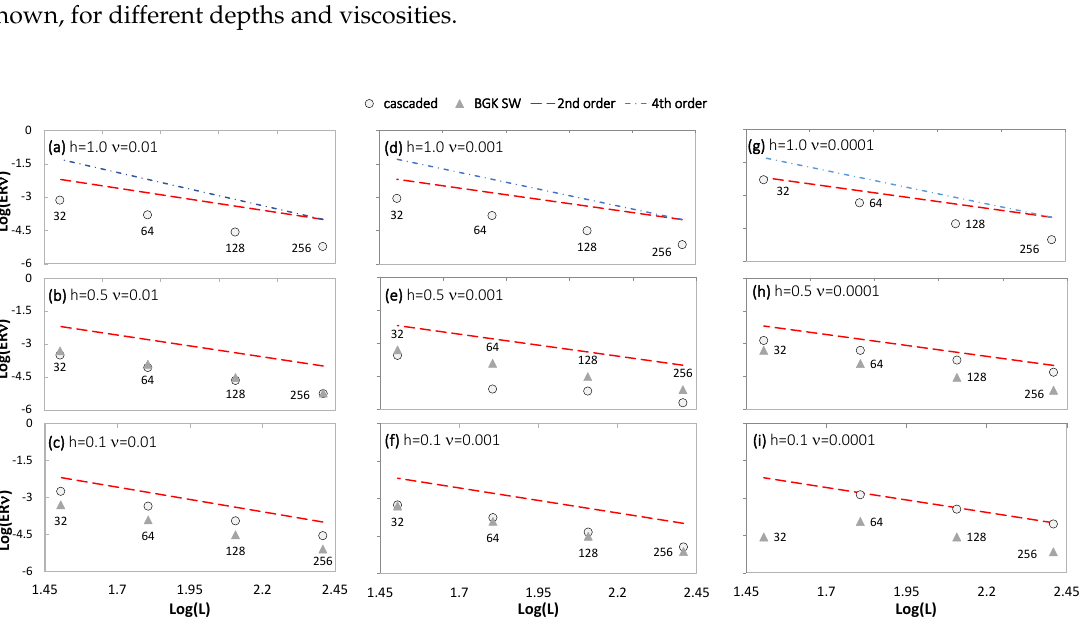
Figure A1. Taylor Green Vortex test. Slow velocity set—comparison of normalized error in viscosity ER ν , for the three depths: h = 1.0 , 0.5 , and 0.1 and three viscosities: ν = 0.01, 0.001, and 0.0001. The label shows the different values of the domain width L